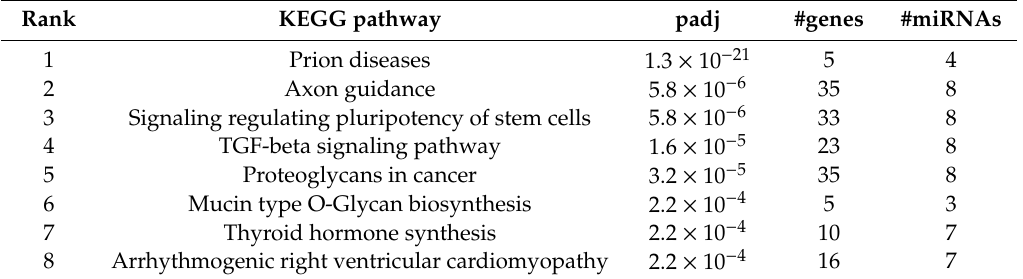
Table 2. KEGG pathways for the up-regulated miRNAs in clinical-stage Tg501 mice (padj < 0.001). Rank KEGG